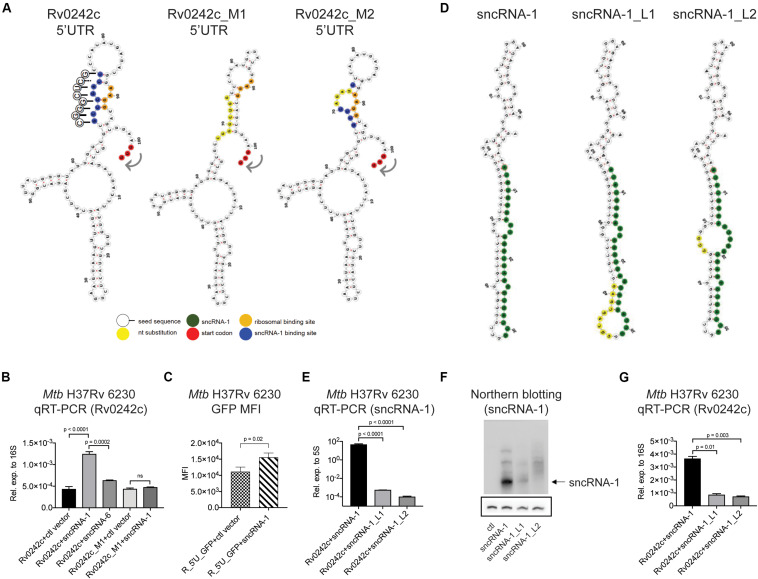
sncRNA-1 uses a seed sequence to positively regulate the expression of Rv0242c required for oleic acid synthesis. (A) Predicted secondary structure of the 5′ UTR of Rv0242c, Rv0242c_M1, and Rv0242c_M2 are shown, which were modeled using RNAfold web server. The start codon is shown in red, the proposed sncRNA-1 binding site is shown in blue, and mutated nucleotides are shown in yellow. The predicted ribosomal binding site, containing an AAGG sequence, hybridizes with the predicted sncRNA-1 binding site in the 5′ UTR of Rv0242c. The sncRNA-1 seed sequence interacting with the proposed sncRNA-1 binding site is shown in circles. The complementary sequences are shown with solid lines whereas the non-complementary sequence is shown with a dashed line. (B) Rv0242c along with its promoter region including the 5′ UTR was cloned into a protein expression vector called pSUM-Kan-MCS1-gfp. The kanamycin cassette was replaced by a Zeocin resistance cassette and GFP was replaced by the Rv0242c. Plasmids expressing the control vector or sncRNA-1 or sncRNA-6 were co-electroporated into Mtb H37Rv 6230 along with the Rv0242c expression vector. sncRNA-6 was used as a negative control. Individual transformants were obtained following selection in media containing two antibiotics. RNA was isolated from cultures at stationary phase, and Rv0242c expression was quantified relative to 16S rRNA by qRT-PCR. p-values are calculated using one-way ANOVA. (C) A reporter assay was developed in which the 5′ UTR of Rv0242c was cloned upstream of the cDNA for GFP. This construct was co-expressed with either ctl vector or the sncRNA-1 expression vector. Median GFP intensity was quantified in cultures at stationary phase. For statistics, student t-test was used. (D) Nucleotide substitutions were introduced in the hairpin structure of sncRNA-1 to disrupt its secondary structure and hence processing using site directed mutagenesis. Two distinct mutants were obtained. sncRNA-1 sequence is shown in green and the mutations are shown in yellow. (E–G) sncRNA-1, sncRNA-1_L1, or sncRNA-1_L2 was co-expressed with the putative target Rv0242c in Mtb H37Rv 6230. p-values are calculated using one-way ANOVA. (E) sncRNA-1 expression was quantified relative to 5S RNA as indicated in the axis labels. (F) sncRNA-1 expression was visualized with Northern blotting. The membrane was initially probed for sncRNA-1 and exposed for 24 h. sncRNA-1 was shown with an arrow. The same membrane was stripped and probed for 5S RNA for 3 h. 5S RNA was shown in the box. (G) Rv0242c expression was quantified relative to 16S RNA as indicated in the axis labels. p-values are calculated using one-way ANOVA.